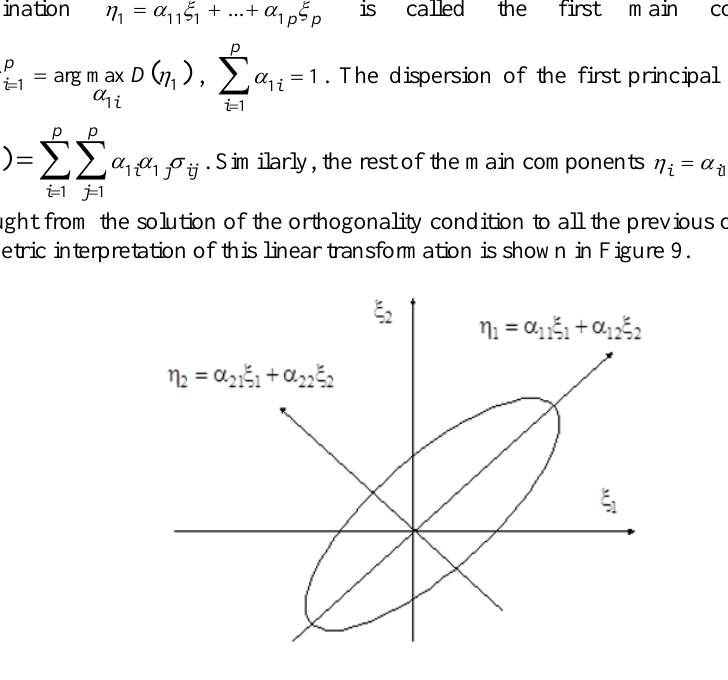
Fig. 9. The geometric interpretation of the main components.